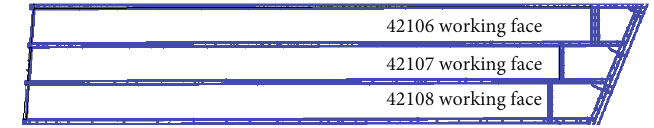
Figure 1: 42106 working face layout.